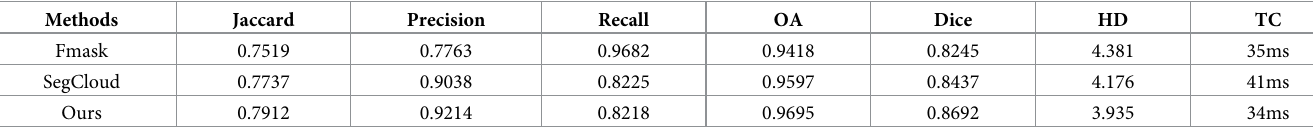
Fig 7. Visual comparison of state-of-the-art satellite cloud image segmentation methods. From top to bottom, (a) are 2 different satellite cloud images, (b) are the ground-truth corresponding to satellite cloud images, (c) are the results of Fmask [9], (d) are the results of SegCloud [17], (e) are the results of our method.